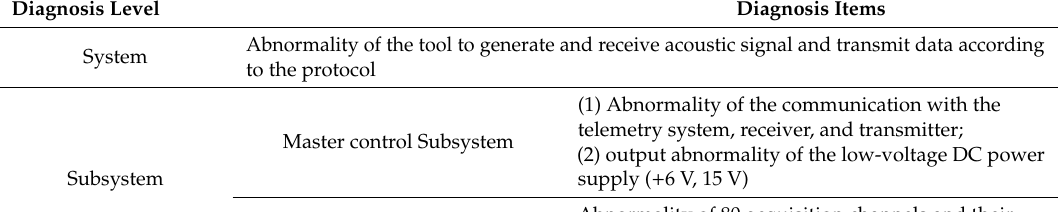
Table 1. Diagnosis items at four levels for the tool.